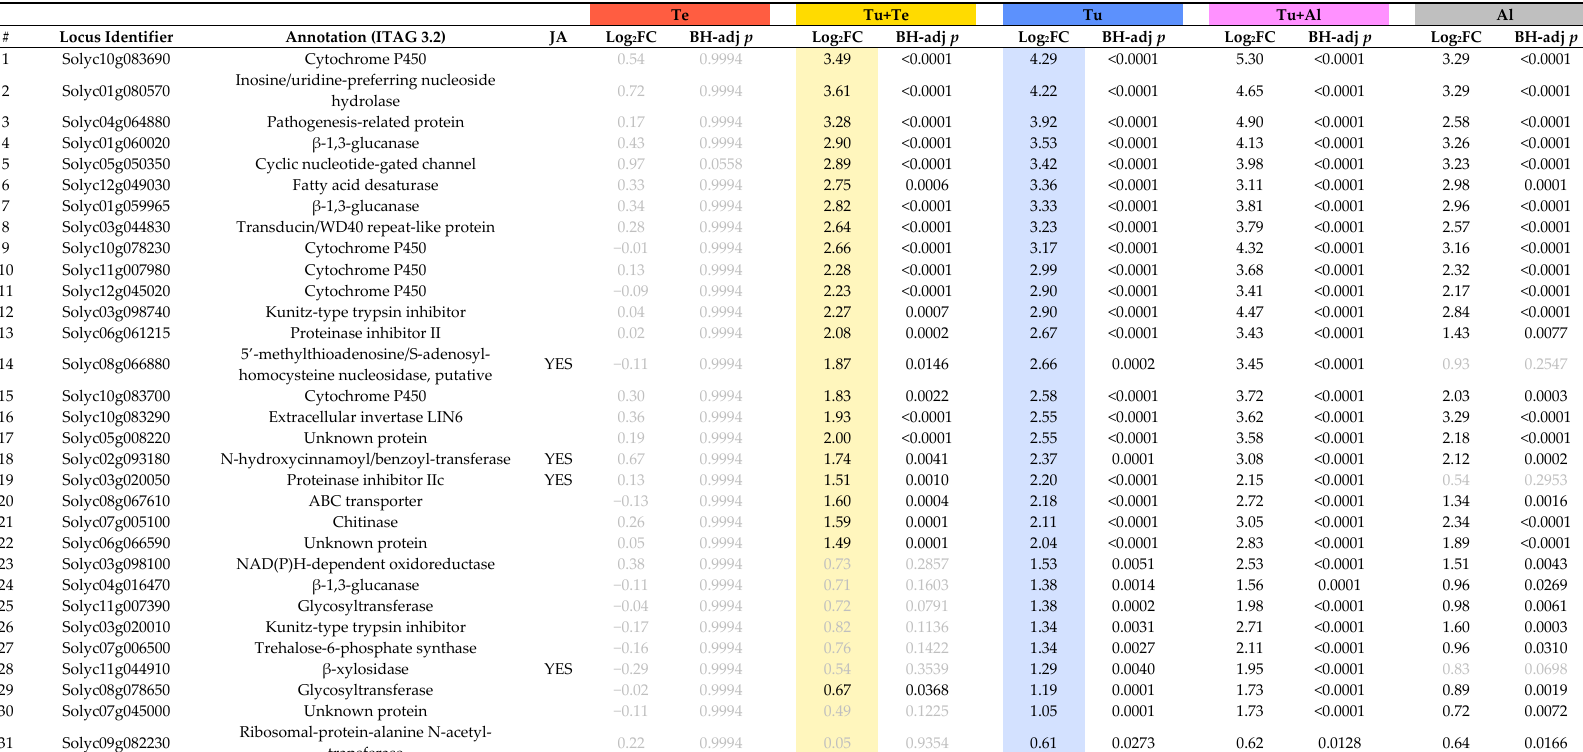
Table 2. List of candidate tomato ( Solanum lycopersicum ) genes whose expression may be suppressed by Tetranychus evansi , i.e., relative to full induction by T. urticae . Shown are Log 2 fold change (Log 2 FC) values of tomato genes upon infestation with either a single mite species ( T. urticae (Tu), T. evansi (Te), or Aculops lycopersici (Al)) or two species simultaneously ( T. urticae plus T. evansi (Tu+Te), or T. urticae plus A. lycopersici (Tu+Al)) as compared to non-infested controls, along with their corresponding Benjamini and Hochberg false discovery rate adjusted p values (BH-adj p ). Information in the column with header “JA” indicates whether expression of the respective gene was found to be significantly induced in the tomato JA-biosynthesis mutant def-1 , 24 h after exogenous application of JA (for details see [39]). Candidate genes were selected based on two criteria: (1) expression is up-regulated (BH-adj p ≤ 0.05) in the Tu sample, while; (2) in the Tu+Te sample such up-regulation is considerably lower (Log 2 FC in Tu (shaded blue) − Log 2 FC in Tu+Te (shaded yellow) > 0.5) or absent. Selected genes were ranked according to their relative expression level in the Tu sample. Grey letters indicate a non-significant (BH-adjusted p > 0.05) change in gene expression. Te Tu+Te Tu Tu+Al Al # Locus Identifier Annotation (ITAG 3.2)